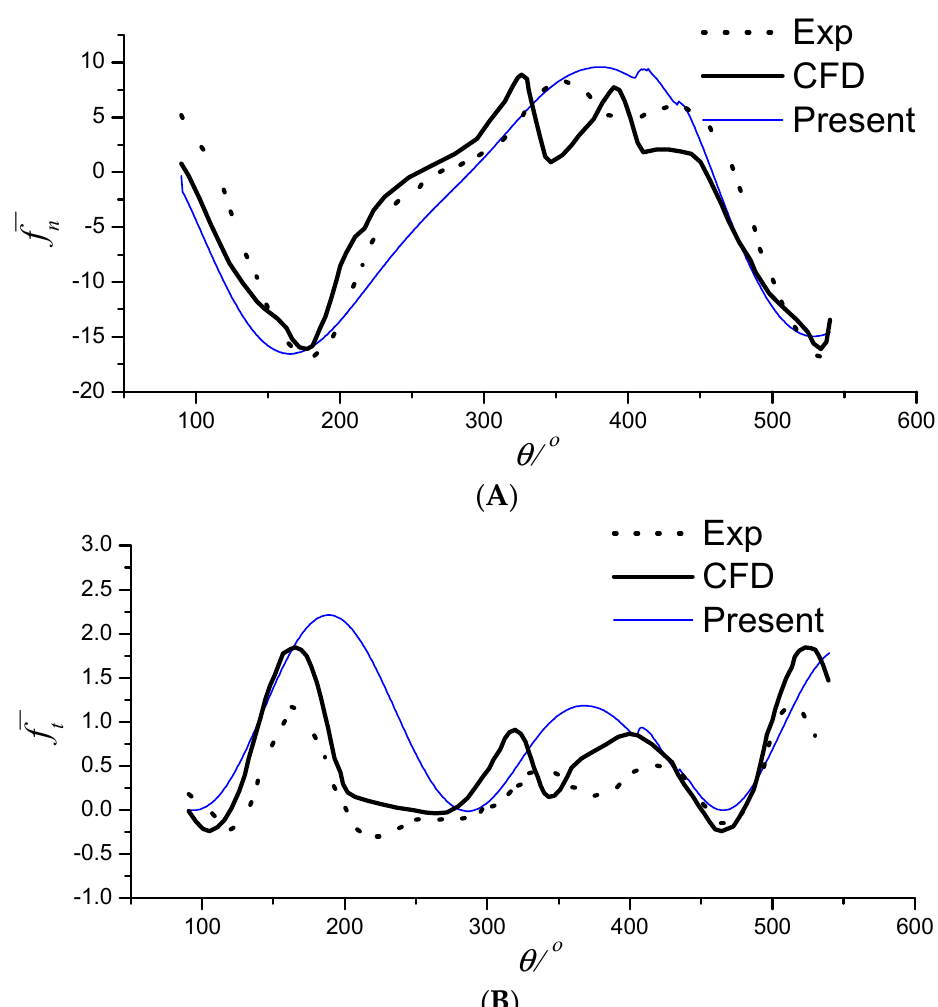
Figure 6. ( A ) Normal force coefficient ( λ = 2.5, Z = 2); ( B ) tangential force coefficient ( λ = 2.5, Z = 2).